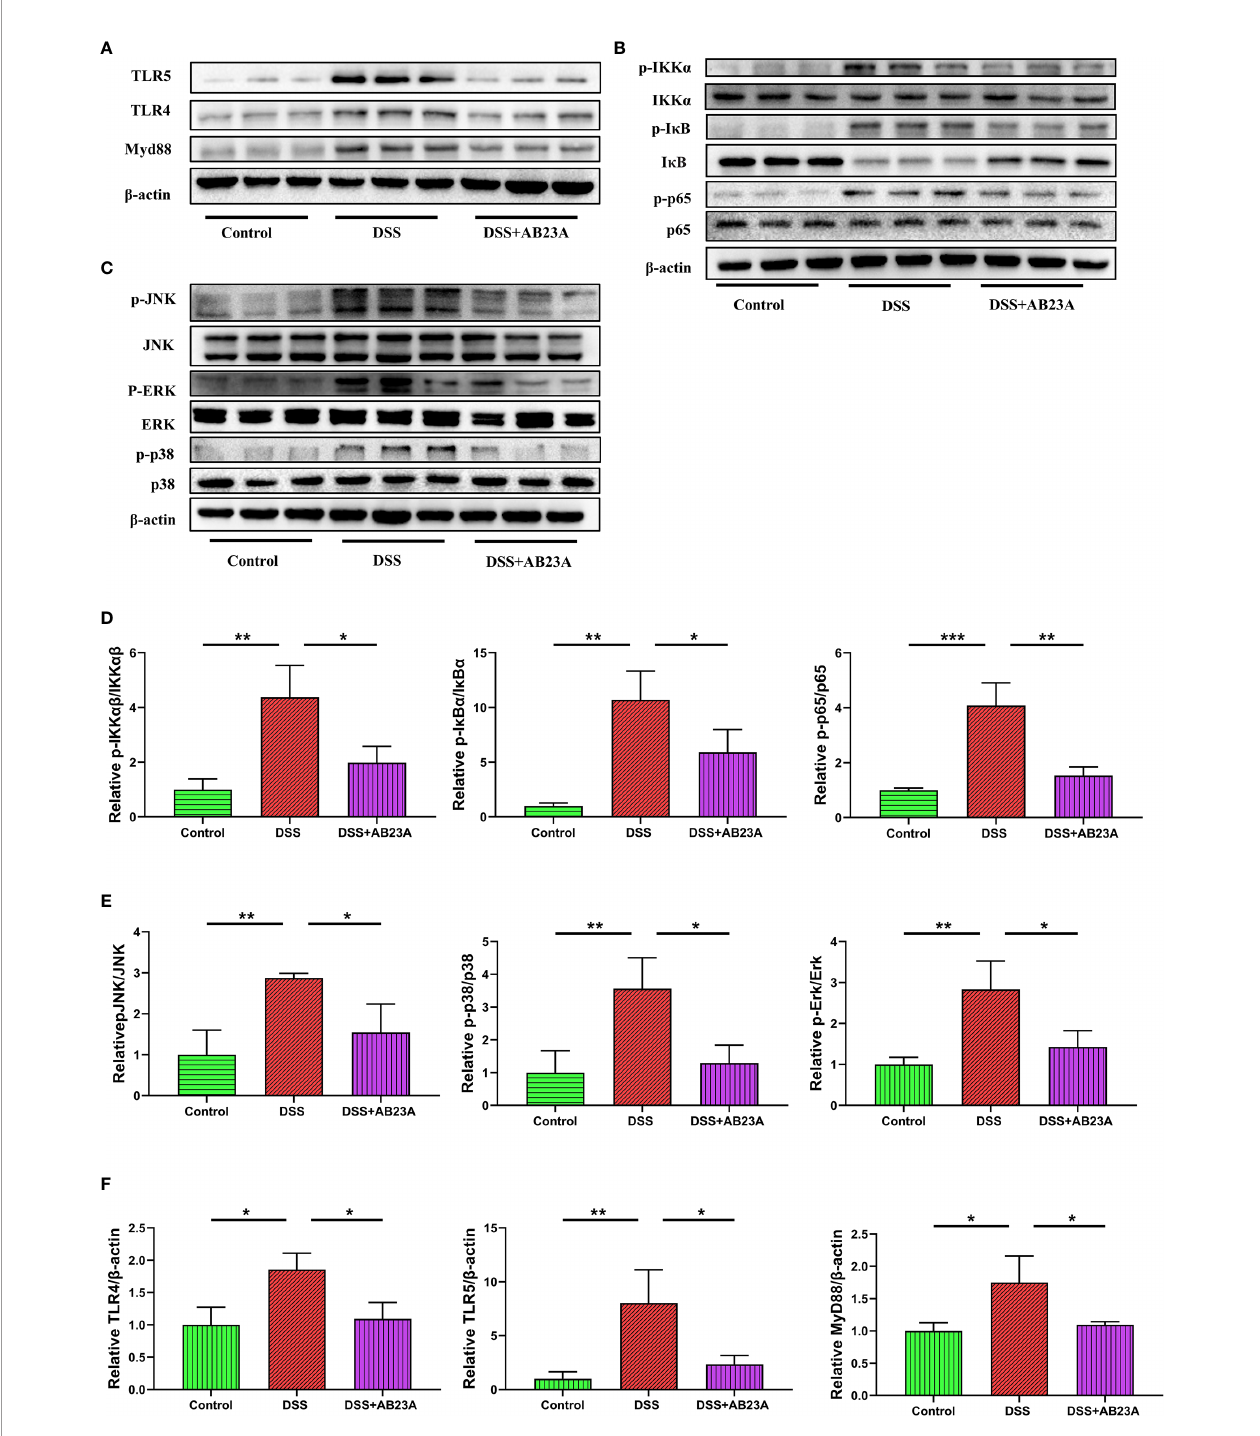
FIGURE 6 | Effects of AB23A on the activation of TLRs, NF- k B and MAPK in colonic tissue of CAC mice. (A) Immunoblotting of TLR4, TLR5 and MyD88 in colon tissue. (B, C) Immunoblotting of total and phosphorylated IKK a I k B a , and p65 and total and phosphorylated JNK, ERK, and p38 in colon tissue. (D) p-IKK a , p- I k B a , and p-p65 protein expression relative to IKK a , I k B a , and p65. (E) p-JNK, p-ERK, and p-p38-MAPK protein expression relative to JNK, ERK, and p38-MAPK. (F) TLR4 and MyD88 protein expression relative to b -actin. Data are expressed as mean ± SD (n = 3). Differences were analyzed by one-way ANOVA followed by Tukey ’ s post hoc test (*P < 0.05, **P < 0.01, ***P <